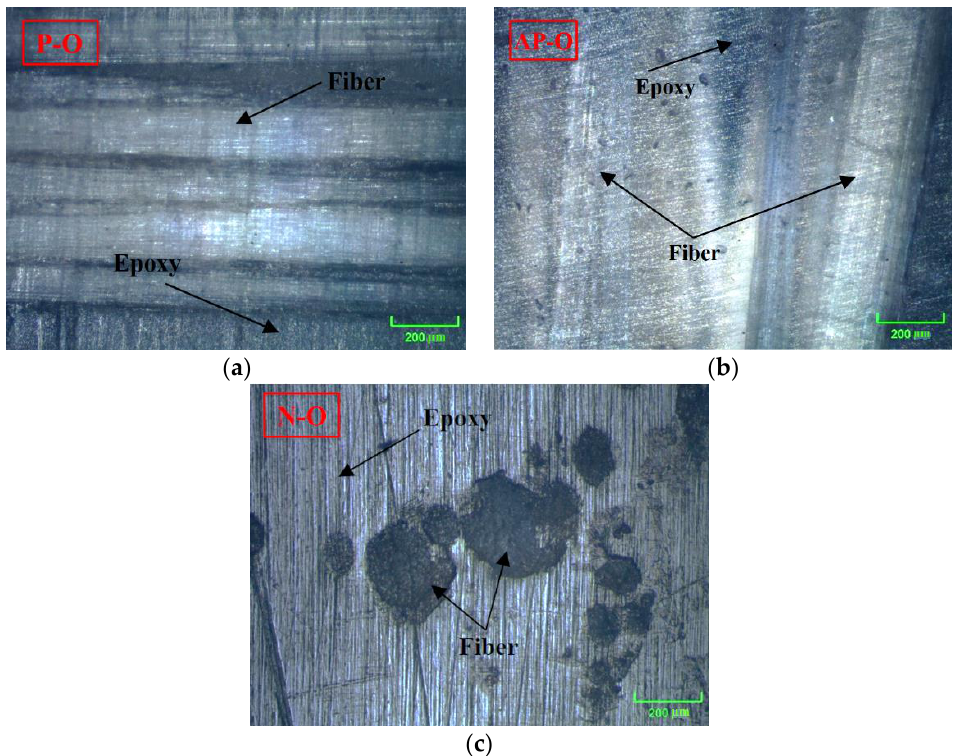
Figure 2. Optical microscopy of contact surface prior to tribological test: ( a ) parallel, ( b ) anti-parallel and ( c ) normal.